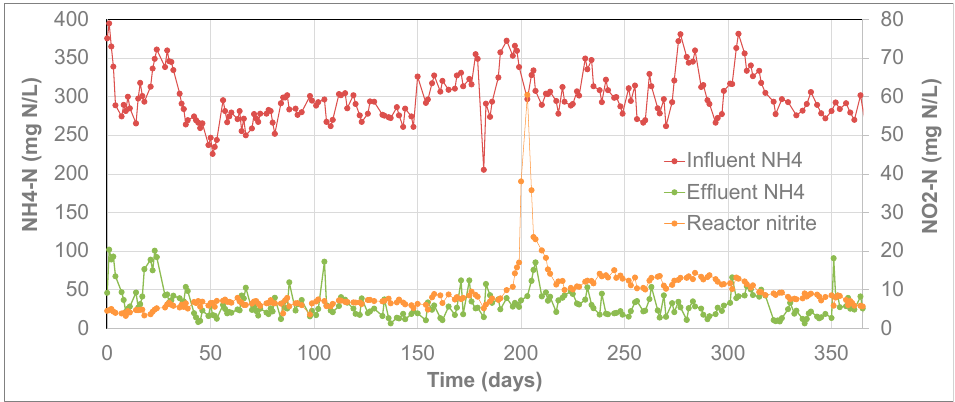
Figure 11. Operational data from a PN/A ANAMMOX reactor.